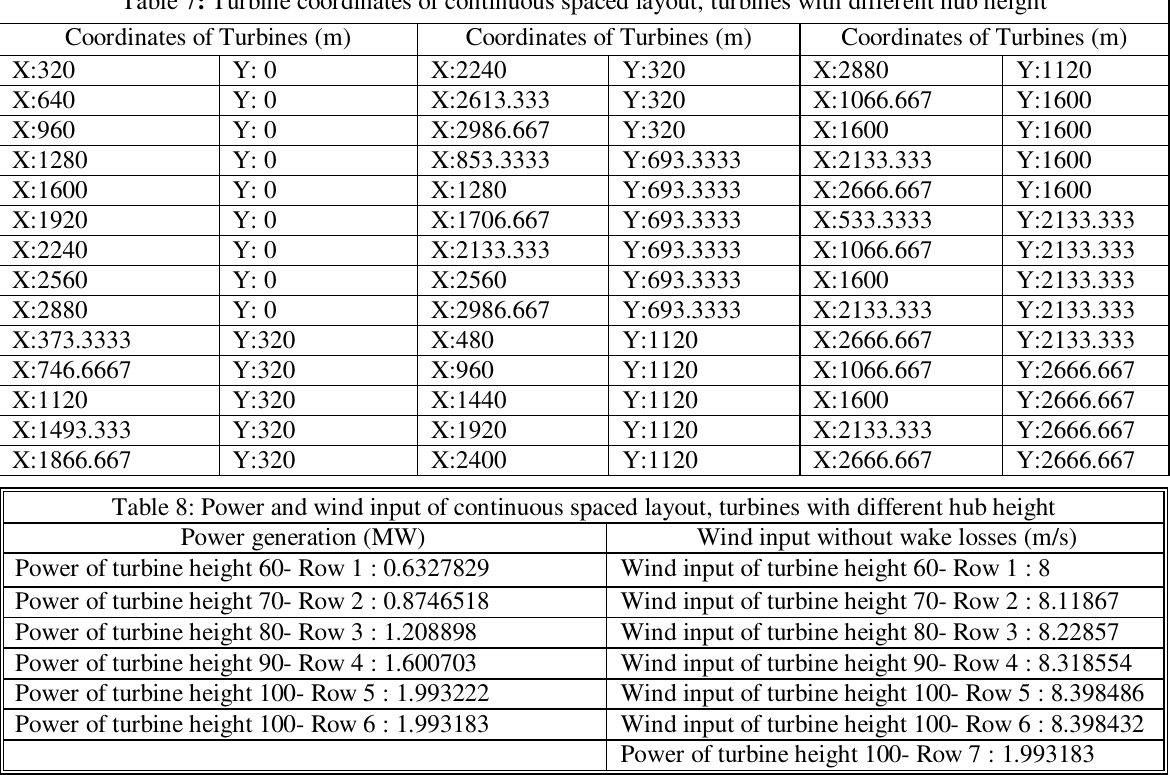
Table 7 : Turbine coordinates of continuous spaced layout, turbines with different hub height Coordinates of Turbines (m) Coordinates of Turbines (m) Coordinates of Turbines (m)